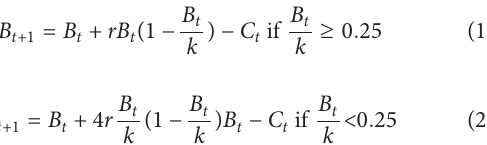
TABLE 1 | De fi ning fi sh population status based on the B/B MSY and F/F MSY of the last year in the time series. B / B MSY F / F MSY ≥ 1 <1